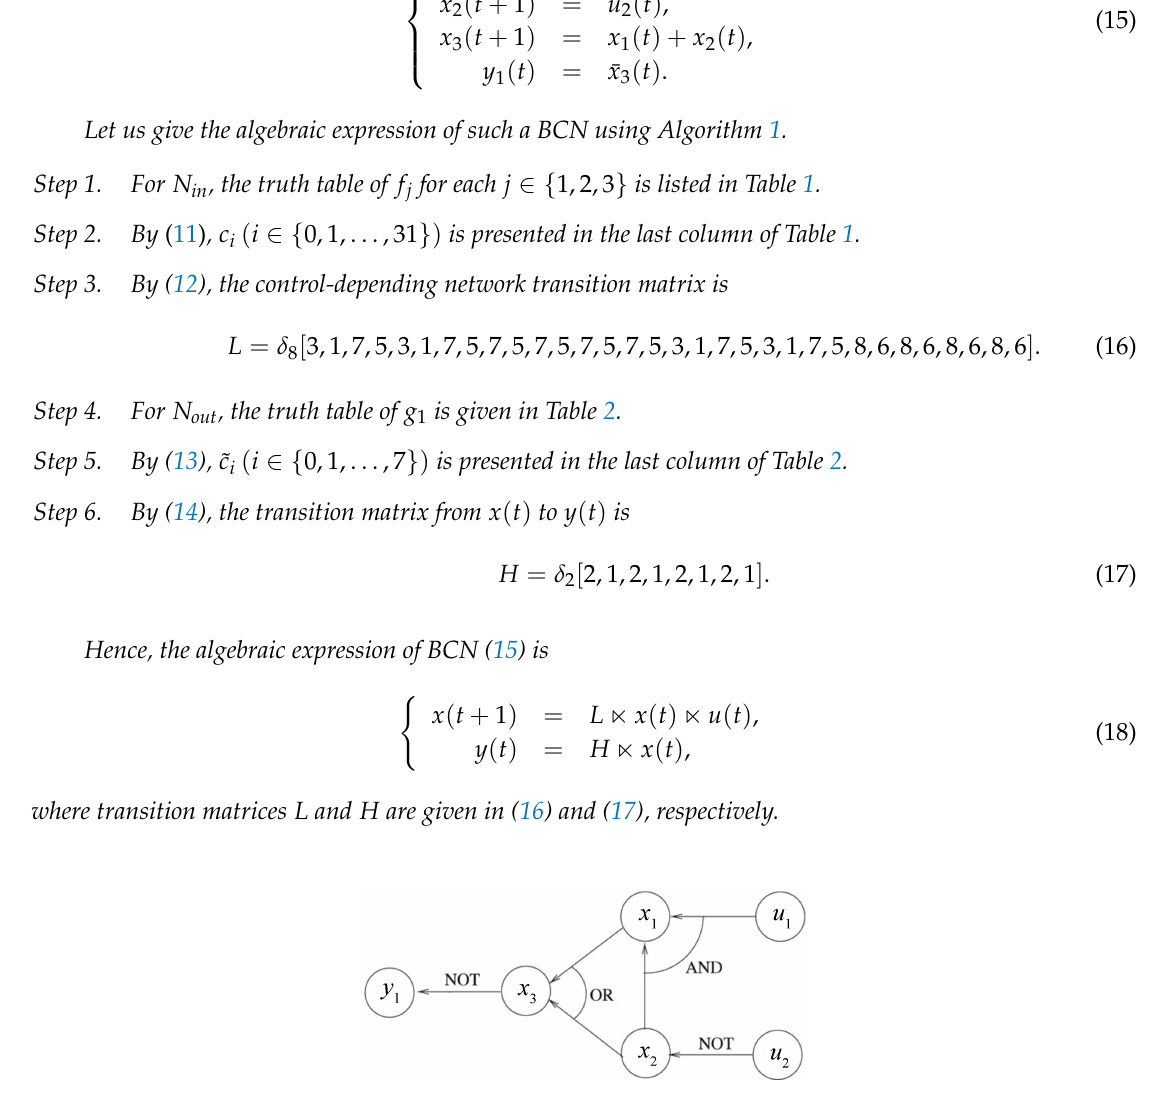
Figure 1. Boolean control